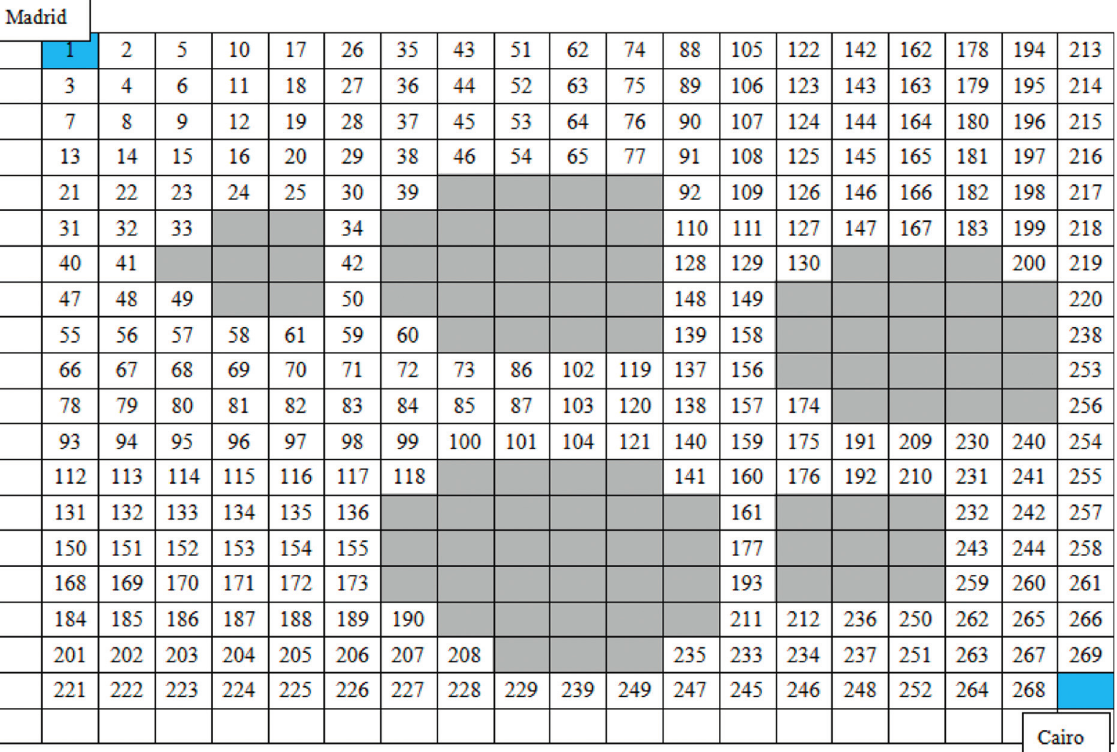
Figure 16: The searching process of traditional A-star algorithm from Madrid to